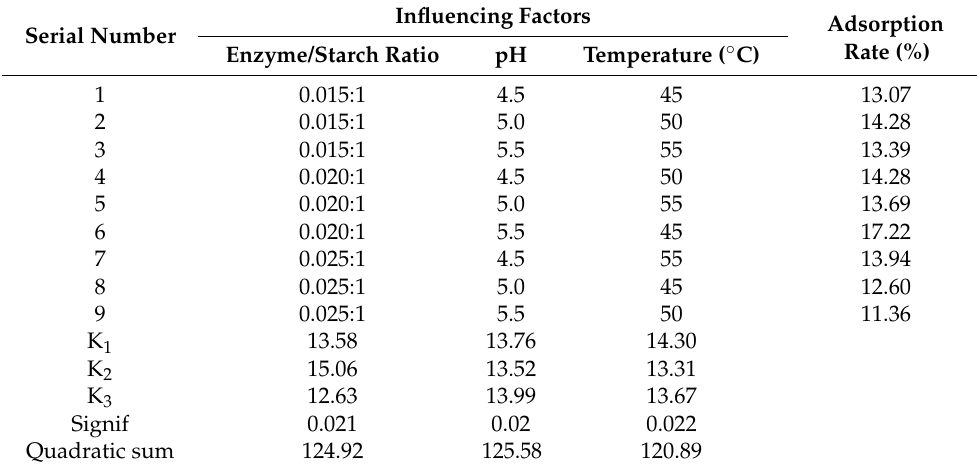
Table 3. Results of the orthogonal